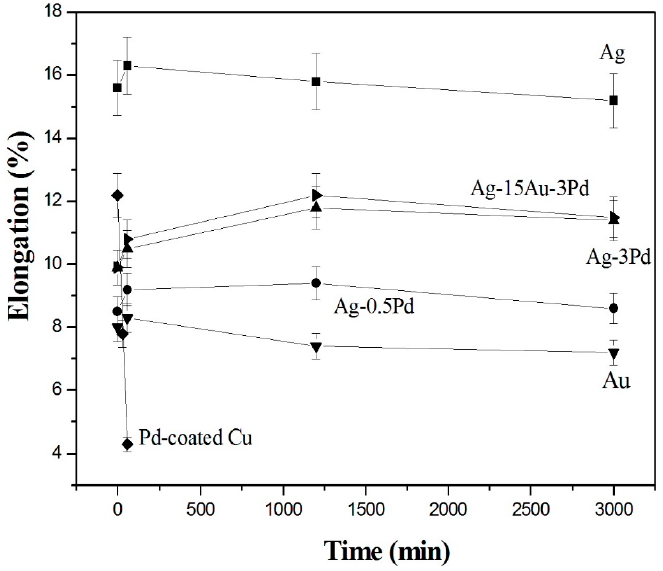
Figure 12. Variations of the elongations of bonding wires after current stressing at 1.23 × 10 5 A/cm 2 for various times.